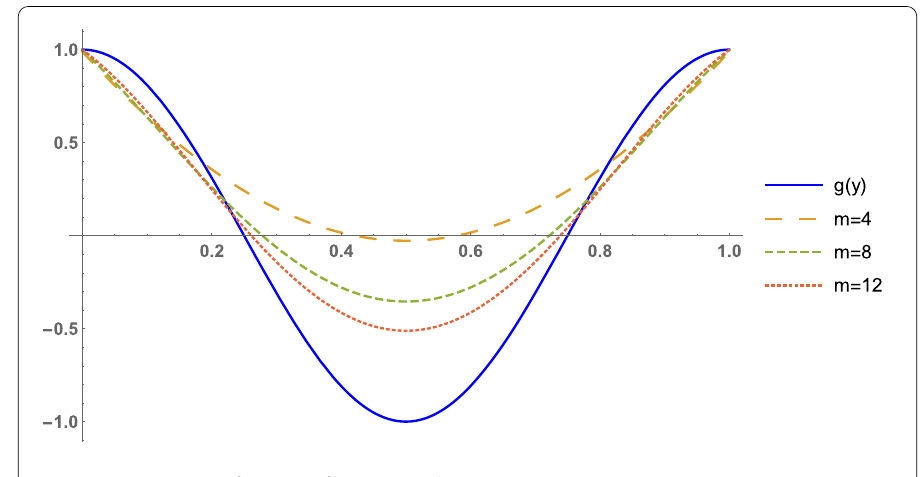
Figure 1 Convergence of operators for some m values